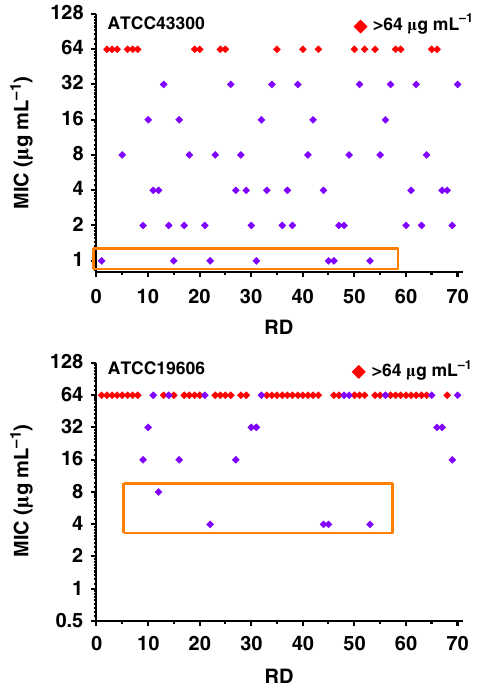
Fig. 3 Activity of RD1 - RD70 against MRSA and Acinetobacter baumannii . The MIC ( μ g mL − 1 ) of each compound was measured by the standard CLSI